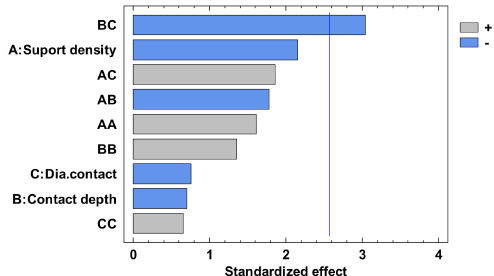
Figure 34. Standardized Pareto Chart for Roundness